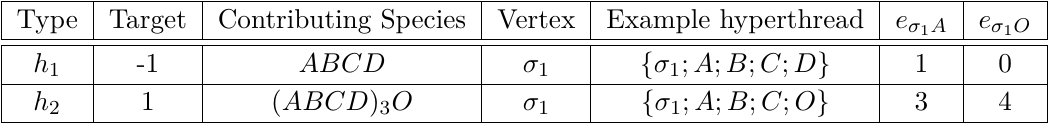
consists of a single negative thread 1 . Shown is the 3 O